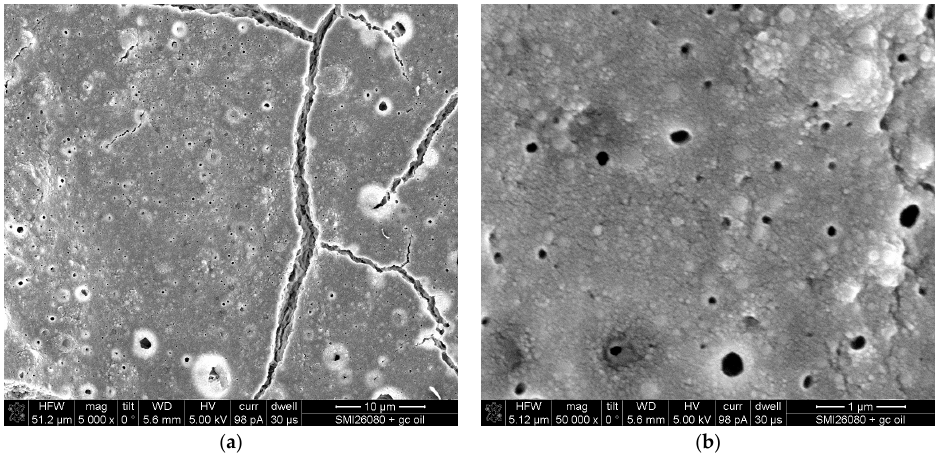
Figure 2. Detailed FEG-SEM microscopy of SMI/oil coating on paper (e.g., SMI/HCO): ( a ) magnification 5000×; ( b ) magnification 50000×.